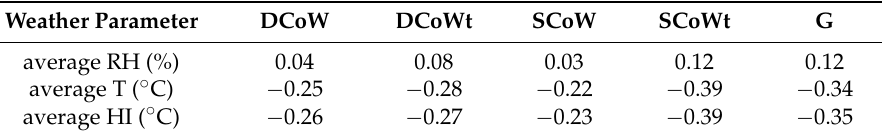
Table 5. Correlation between growing season-only EVI for each land-cover type and weather parameters. Land-cover types: dense cork oak woodlands with understorey (DCoW), dense cork oak woodlands without understorey (DCoWt), sparse cork oak woodlands with understorey (SCoW), sparse cork oak woodlands without understorey (SCoWt), and grasslands (G). Weather Parameter DCoW DCoWt SCoW SCoWt G average RH (%) 0.04 0.08 0.03 0.12 0.12 average T ( ˝ C) ´ 0.25 ´ 0.28 ´ 0.22 ´ 0.39 ´ 0.34 average HI ( ˝ C) ´ 0.26 ´ 0.27 ´ 0.23 ´ 0.39 ´